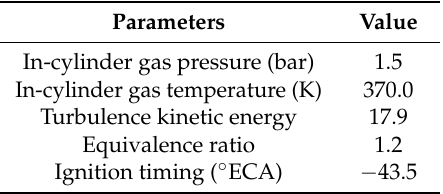
Table 2. The initial simulation parameters of the CFD combustion model.